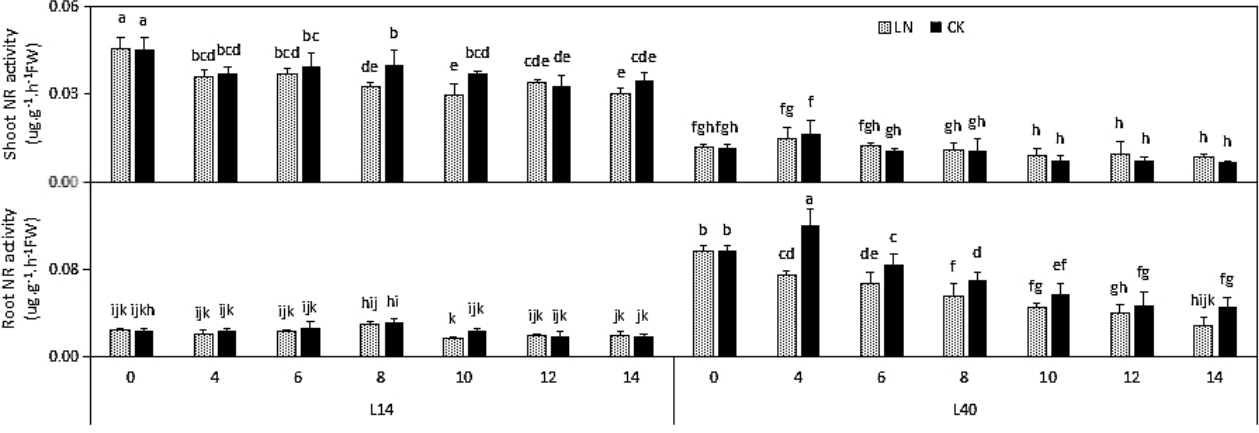
Figure 4. Effects of LN treatment on nitrite reductase (NR) of Chinese cabbage genotypes L14 and L40. Values shown are means ± SE; n = 6 (two experiments and three replications of each genotype). Means with different letters are significantly different according to the Duncan test at p < 0.05. NR changes under LN stress compared to CK content are indicated on the bars. The letters “LN” and “CK” indicate whether the N content was low or normal.